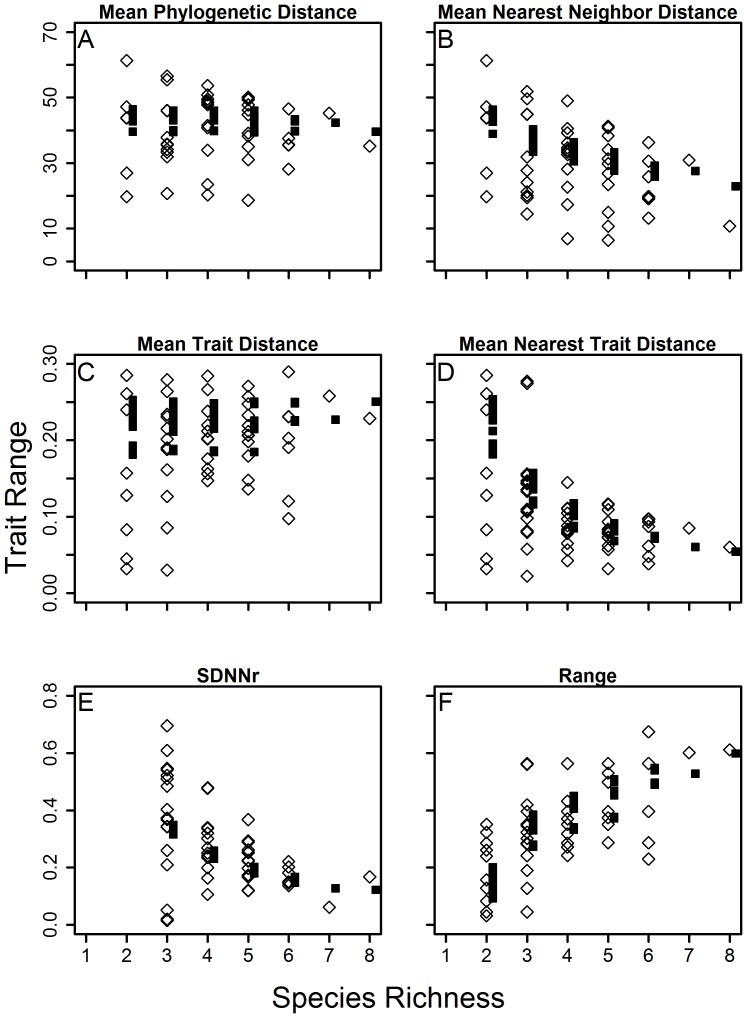
Plot of observed values (diamonds) in communities and expected values (squares) vs. richness for a) Mean Phylogenetic Distance, b) Mean Nearest Neighbor Distance, c) Mean Trait Distance, d) Mean Nearest Trait Distance, e) SDNNr and f) Range.